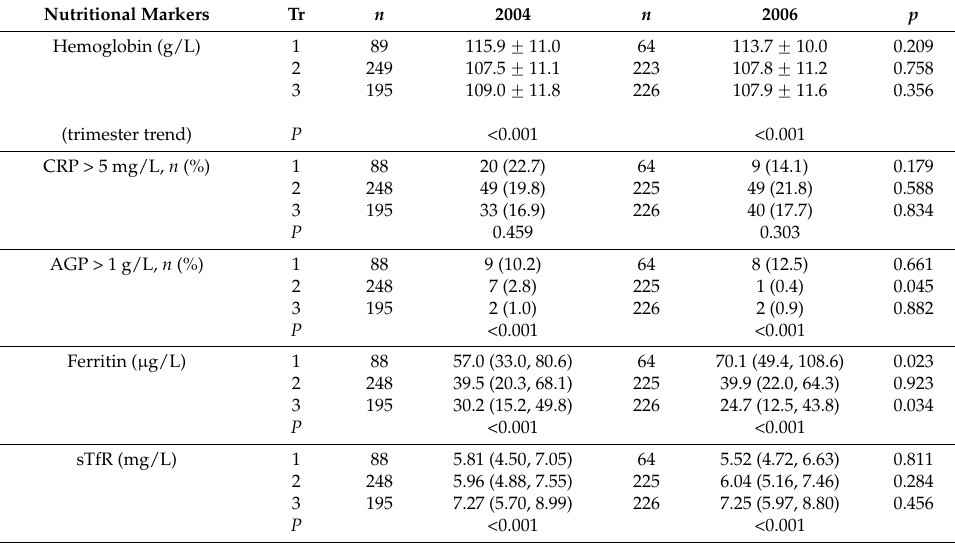
Table 3. Comparison of hemoglobin, blood MNs and nutritional markers between surveys and across trimesters after grouping by trimester of blood draw 1 . Nutritional